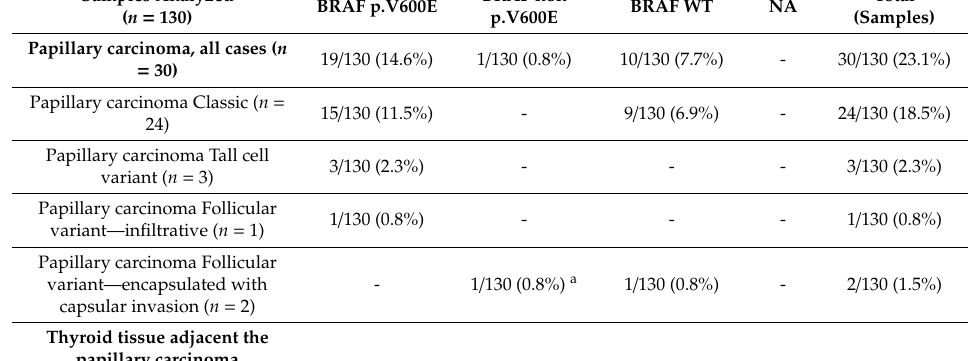
Table 2. BRAF Exon 15 mutations in PTC ( n = 30) and in adjacent thyroid tissue ( n = 100). Samples Analyzed ( n = 130)